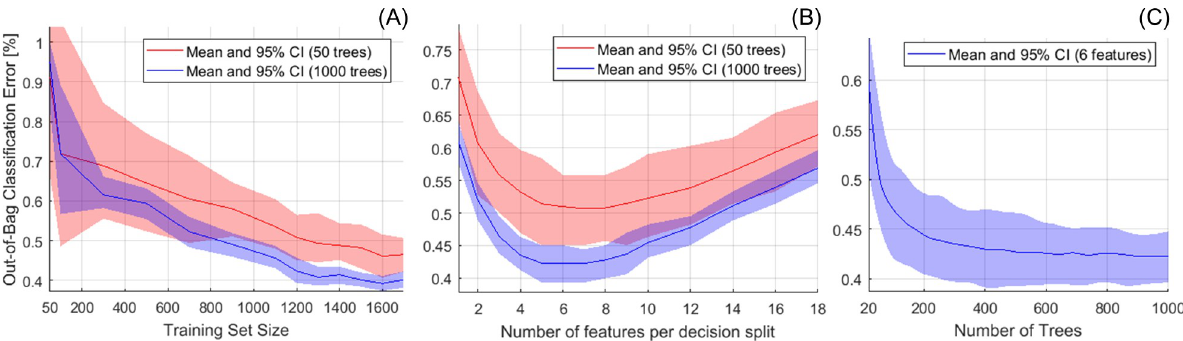
Fig 4. Optimization of the random forest (RF) parameters. Out-of-bag (OOB) mean classification error and CI were calculated from RF training repetitions. A) Training set size for RF with 50 and 1000 trees. B) Number of features per decision split for RF with 50 and 1000 trees. C) Number of trees for RF with 6 features per split. Total number of scans in the training dataset =